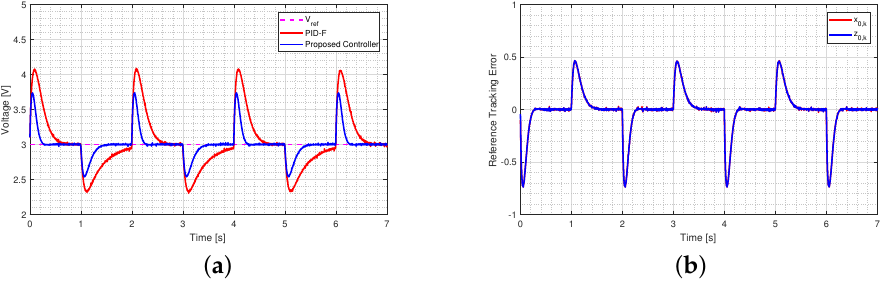
Figure 9. Input voltage variation performance of the proposed controller and a saturated discrete − time PID with τ = 250 µ s. ( a ) Output voltage and reference; ( b ) reference tracking error and its